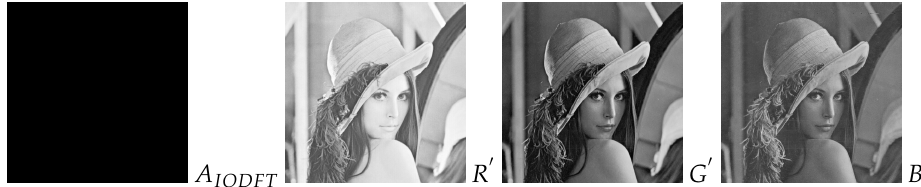
Figure 11. The IQDFT results of the real component A IQDFT , red channel R (cid:48) , green channel G (cid:48) , and blue channel B (cid:48) .